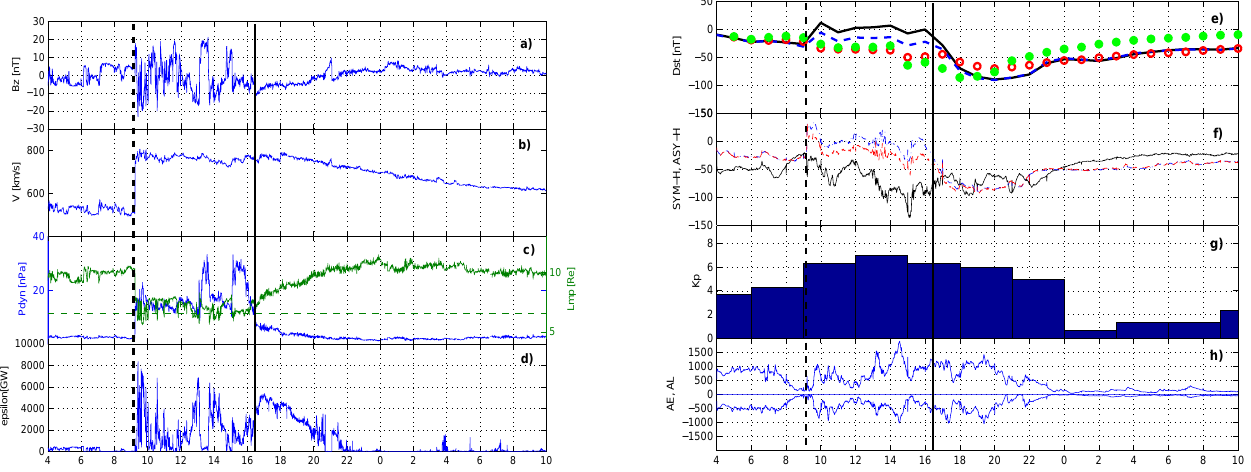
Fig. 5. Solar wind parameters and geomagnetic indices for a 30-h interval from 8 June, 04:00 UT–9 June, 10:00 UT, 2000 measured by ACE. The panels from top to bottom are the same as in Fig. 2. The dashed and solid lines are the same as in Fig.